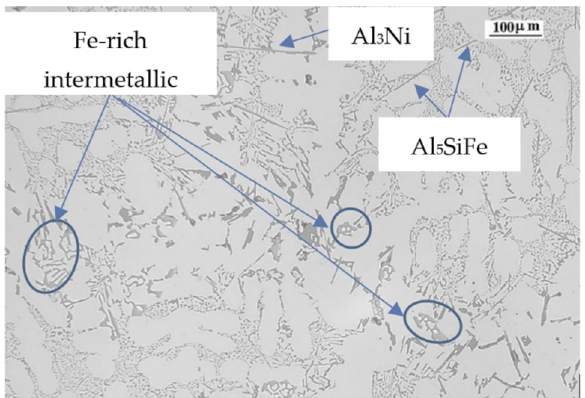
Figure 9. Microstructure of alloy 6.